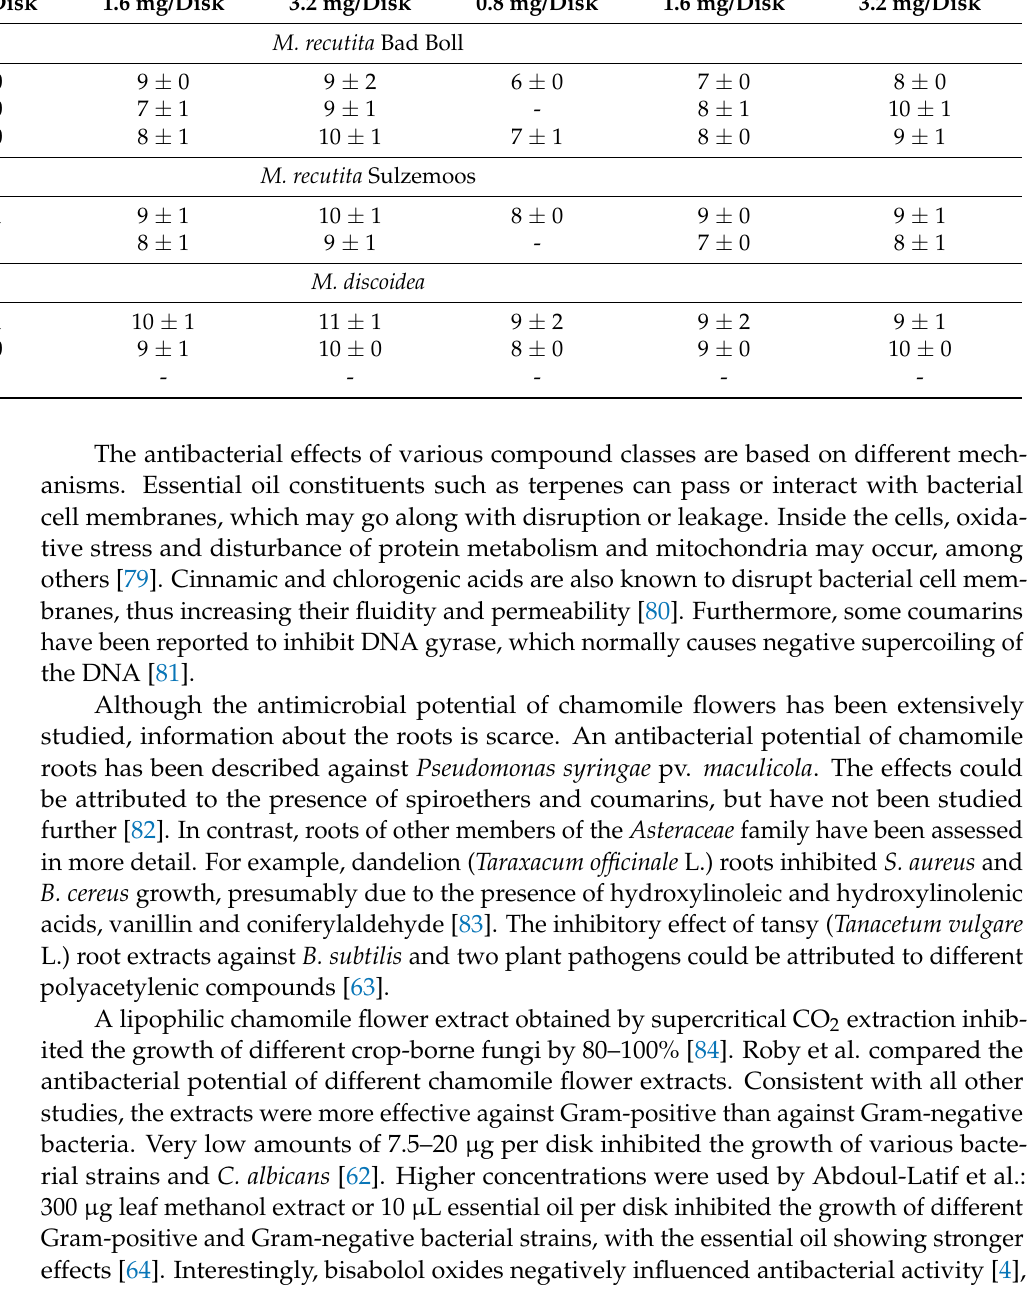
Table 3. Mean inhibition zones in mm against Gram-positive bacterial strains of B. subtilis and S. aureus ( n = 3). S. aureus B. subtilis